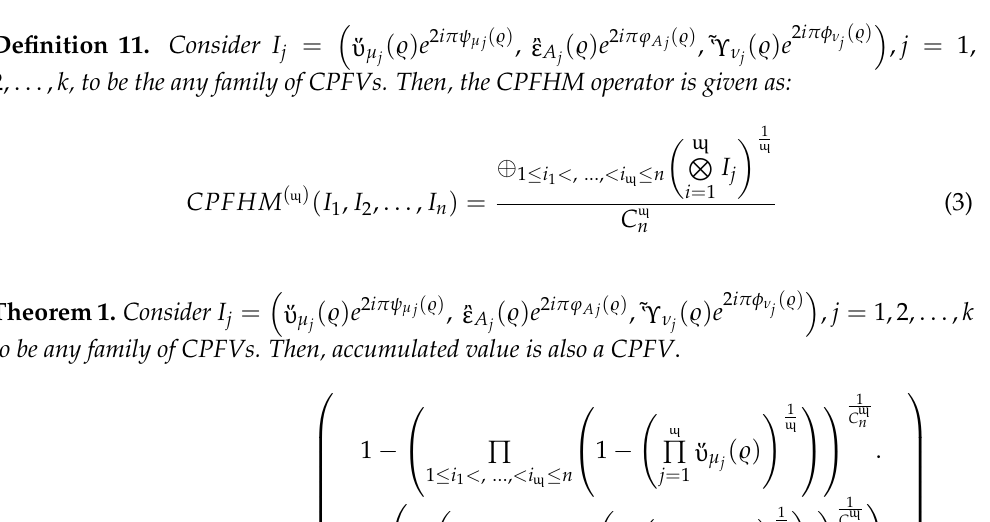
Table 1. Symbols and their